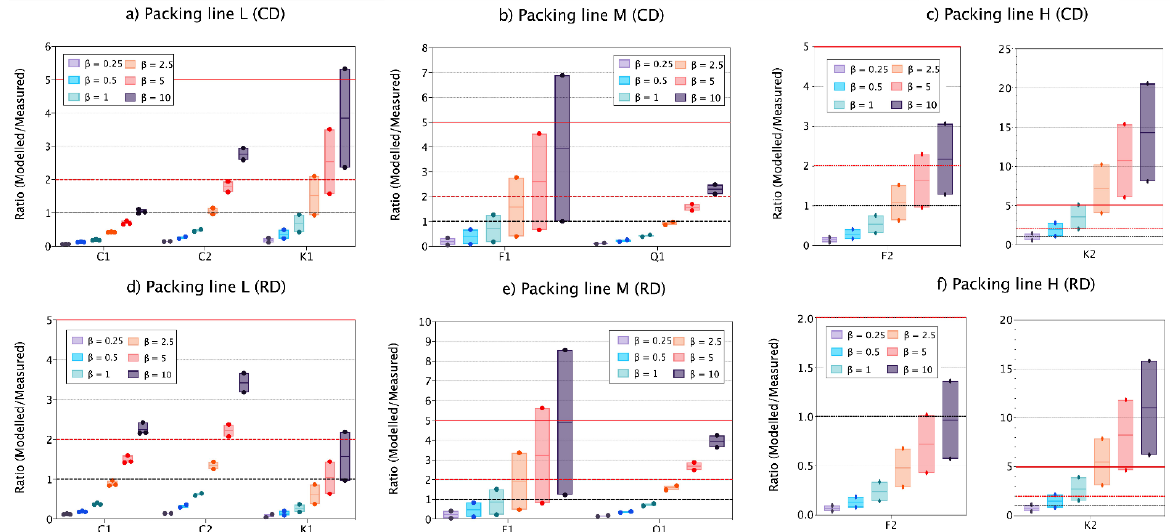
Figure 6. Vertical boxplot for ratio modelled/measured respirable concentrations for all materials when using CD DI ( a – c ) and RD DI ( d – f ) using RD DI as input parameter for source characterisation. Ratios 1, 2 and 5 are marked as reference (red solid line, red dashed line and black dashed lines, respectively). Solid coloured line within the box indicates the median value. Modelling parameters: LEV and fixed at 70%.